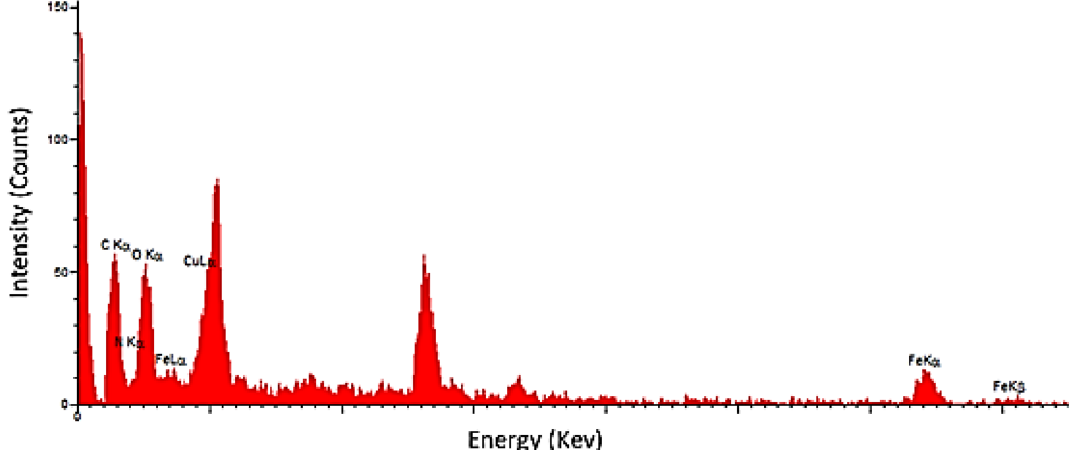
Figure 5. EDX analysis of SSE@GO-CuFe 2 O 4